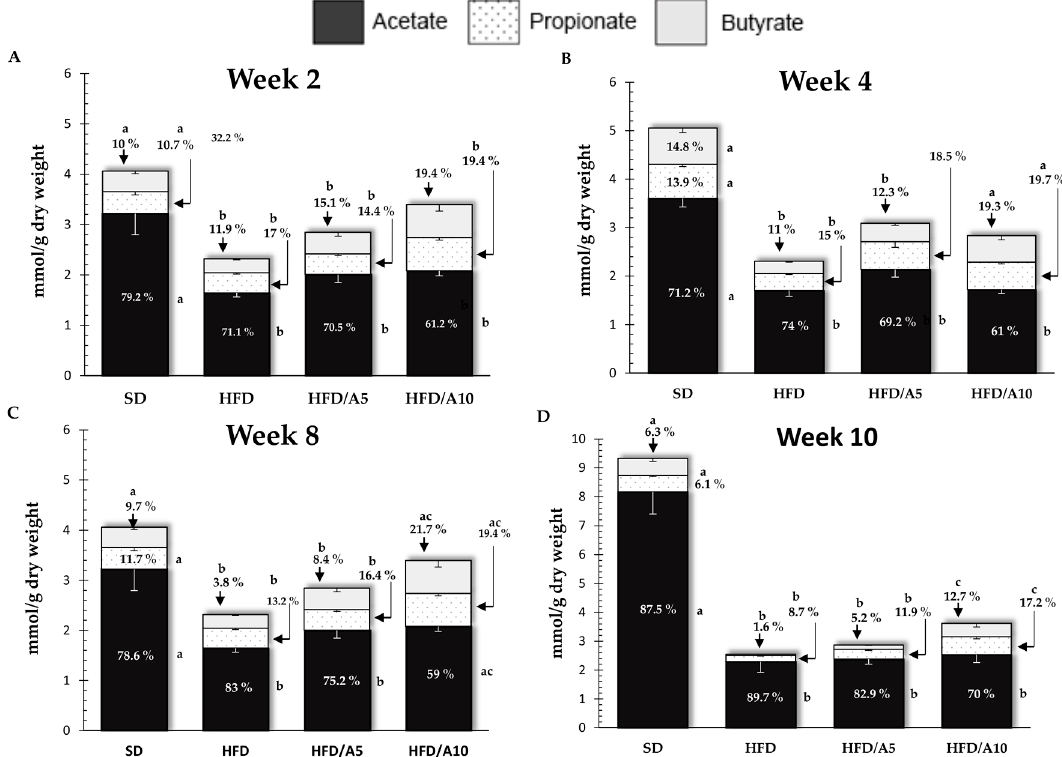
Figure 2. Total fecal mice SCFAs levels at ( A ) 2 weeks, ( B ) 4 weeks, ( C ) 8 weeks and ( D ) 10 weeks. SD, standard diet; HFD, high-fat diet; HFD/A5, high-fat diet supplemented with 5% agavins; HFD/A10, high-fat diet supplemented with 10% agavins. One-way ANOVA and Tukey contrasts were performed to establish differences among groups. The data are represented as the mean with their standard errors of the mean (SEM). N = 10. Mean values with unlike letters (a,b,c) were significantly different ( p < 0.05).